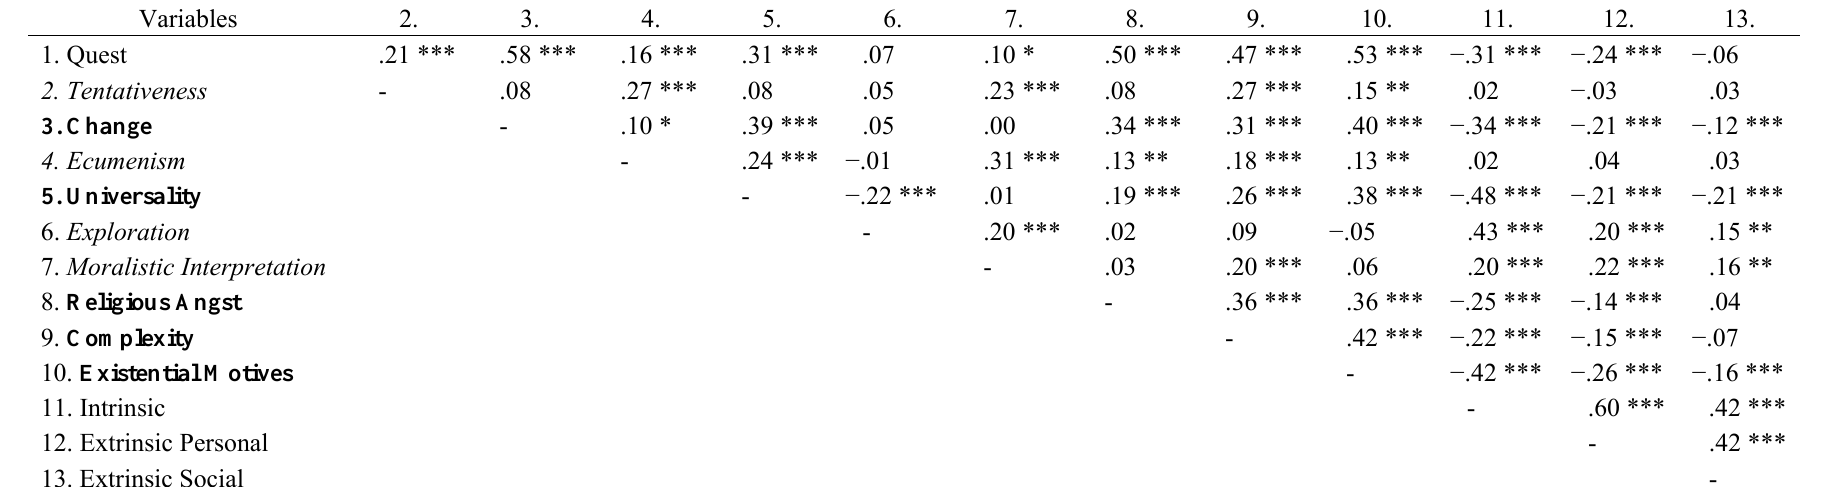
Table 1. Correlations among Quest and Religious Orientation Measures